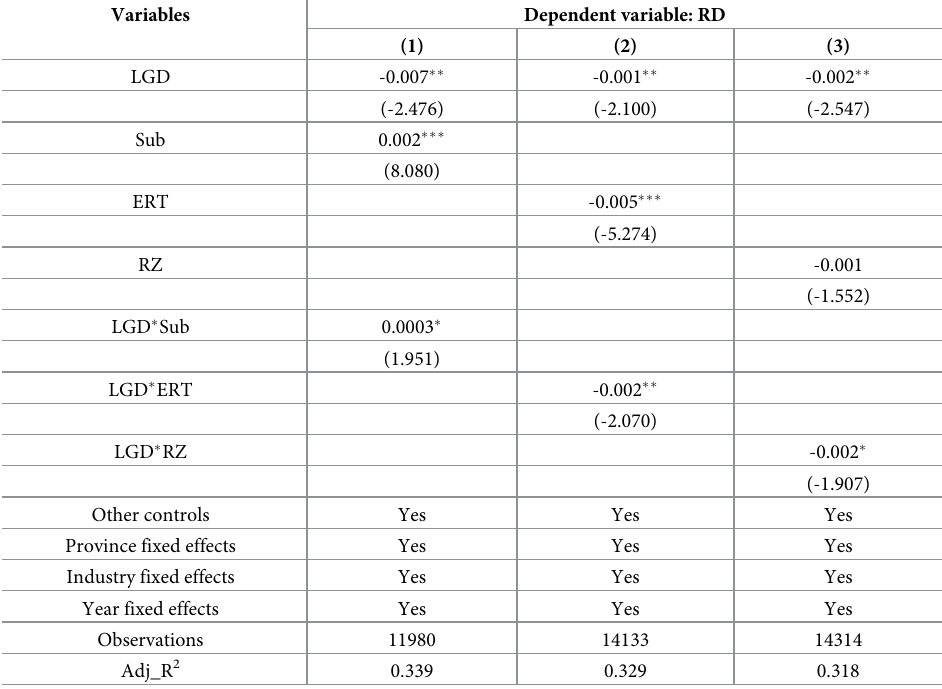
Table 5. Mechanism